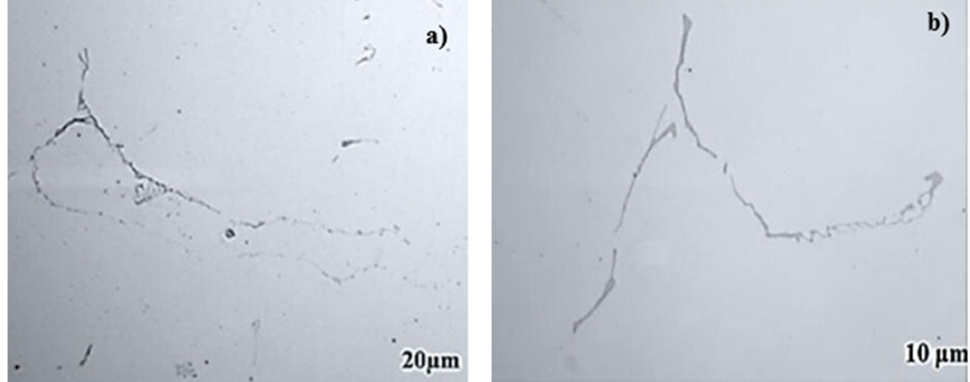
Figure 1. Photomicrographs of the alloy A6063 in the as-cast condition at 500× ( a ) and 1000× ( b ).